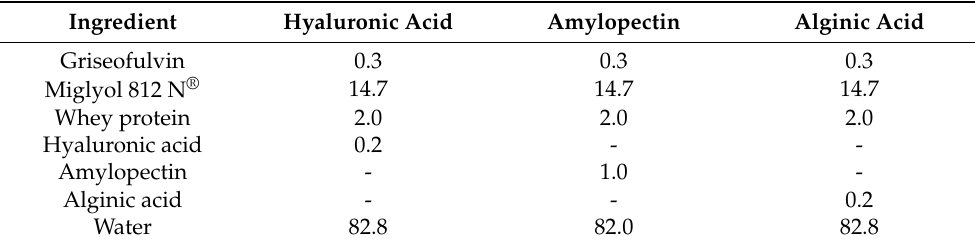
Table 1. Composition of secondary emulsions. Whey protein formed the first layer in all cases followed by the polysaccharide. Compositions are provided as % ( w / w ).